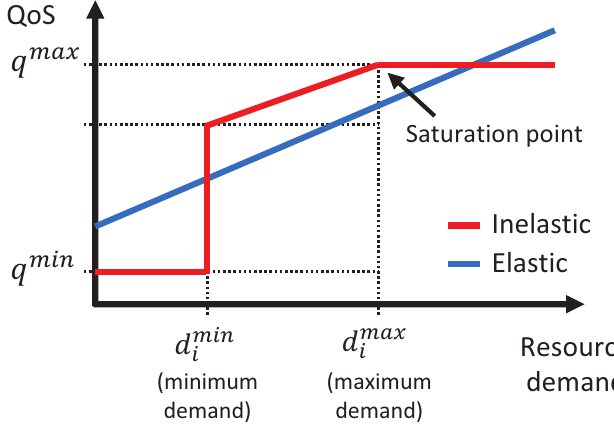
Figure 2. QoS with respect to the resource